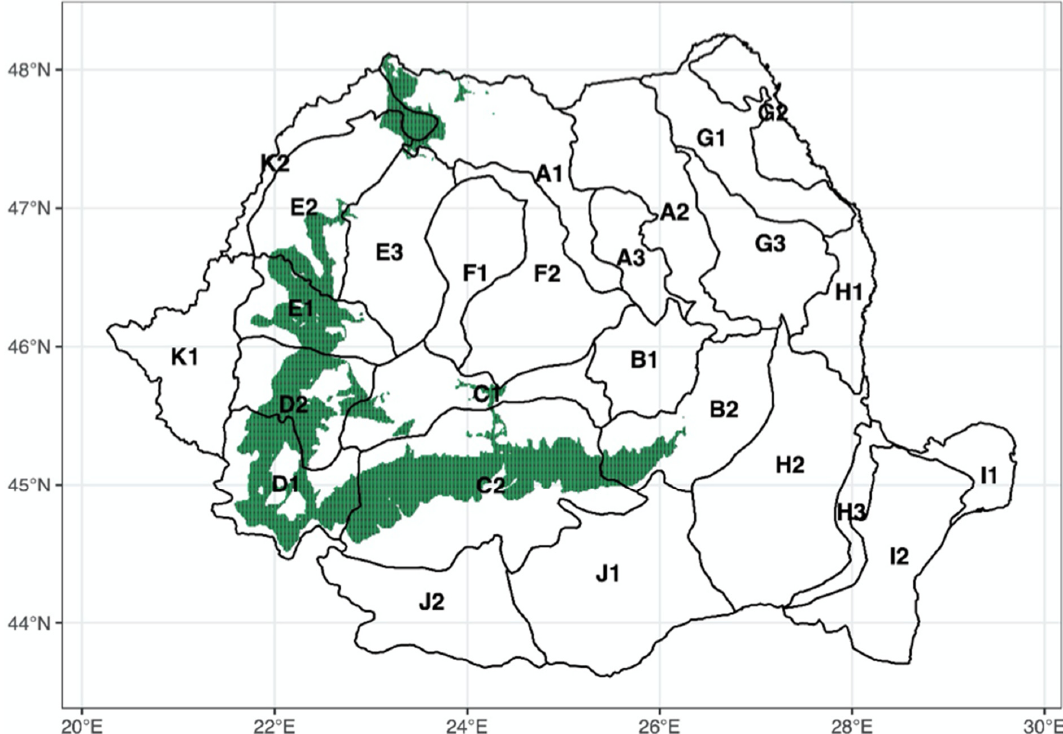
Figure 8. Suitability areas for the Douglas fir in Romania according to the high ‐ resolution climatological data over 1961–2020. The polygons denote the regions of provenance (as in [49]): A1: